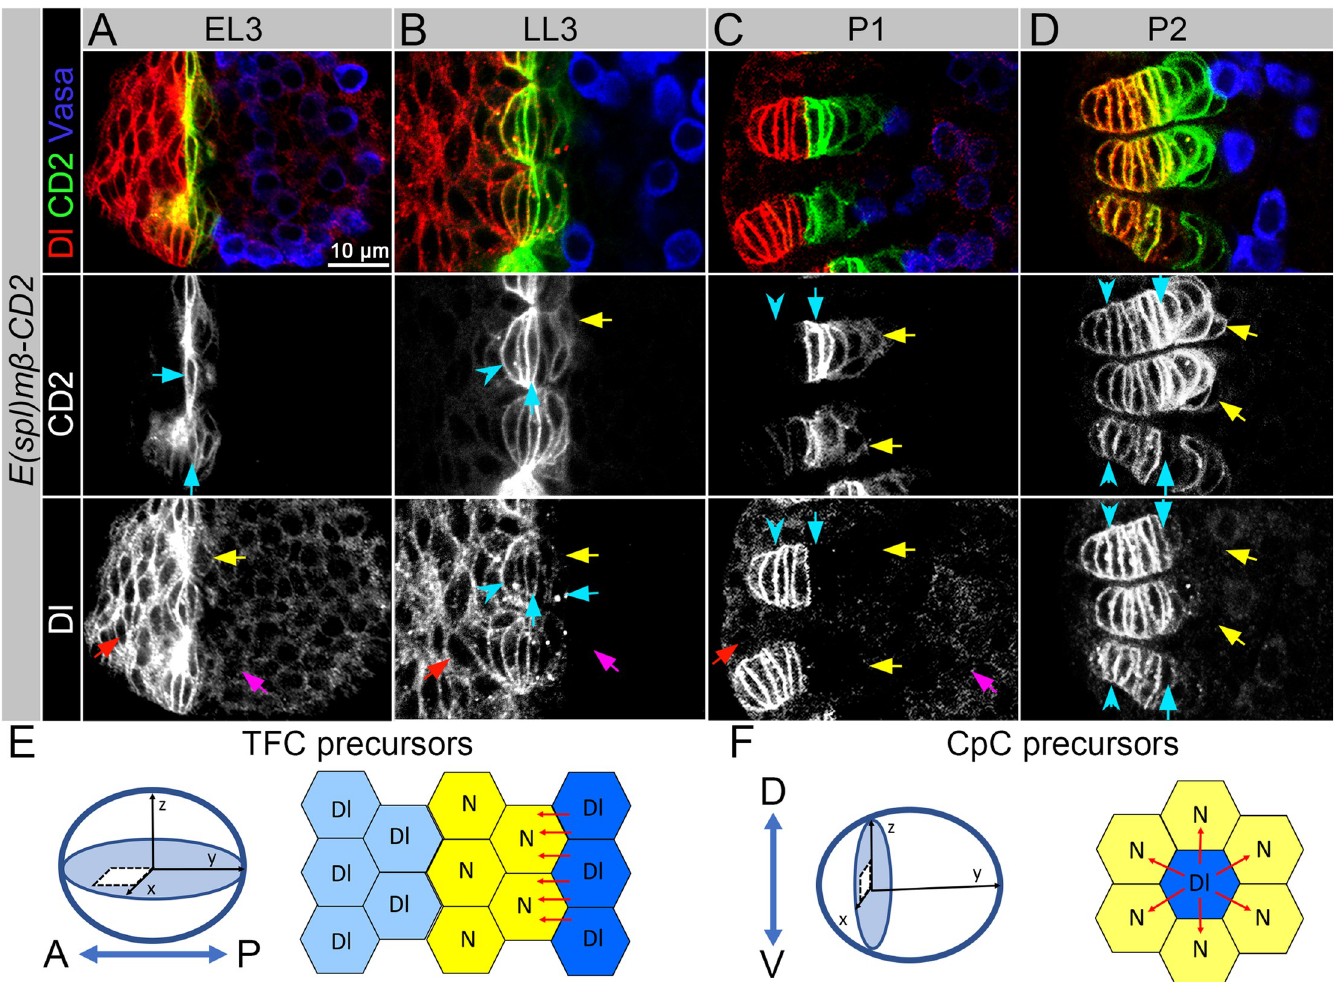
Fig 2. Patterning of Notch signaling at different stages of ovarian morphogenesis. ( A-D ) Co-expression of the Notch activity reporter ( E(Spl)mß-CD2 , green) and the Delta protein (red) in the developing ovaries. Vasa (blue) marks the germline. Single channels for the Notch activity reporter (CD2) and Delta (Dl) are shown below. At EL3 stage, Notch activity is first detected in the early TFCs ( A, cyan arrows). At LL3 and prepupa stages (P1 and P2), lower levels of Notch signaling activity are detected in CpCs ( B and C , yellow arrows) and higher levels in the posterior TFCs (cyan arrow). Note the absence of Notch signaling activity in the anterior TFCs (cyan arrowheads in LL3 and P1). After TFCs and CpCs are specialized, a dynamic Notch signaling activity pattern is observed in these cells (cyan arrow and arrowheads, P2). During all stages, Delta is expressed in ACs (red arrows) and in the germline ICs (magenta arrows); however, its expression levels notably decrease in these cells as organogenesis progresses. In TFCs, Delta expression shows complex dynamics, first, all TFC precursors have high levels of Delta (EL3), as TFCs are organized into individual stalks, Delta levels remain high in the anterior TFCs (cyan arrowheads) and are reduced (LL3) and then, absent (P1 and P2) in the posterior TFCs (cyan arrows). Note that some of the posterior TFCs have vesicle-internalized Delta (horizontal cyan arrow), which is important for Notch signaling activation and induction of the stem cell niche cell fate in CpC precursors ( B , yellow arrows). See also the images of the expression patterns of different Notch activity reporters (S2 Fig). (E-F ) GSC niche development is a two-step process, which includes TF formation and CpC specification. Schematics showing positioning and the proposed modes of Notch patterning induction within the developing ovary in TFC precursors ( E ) and CpC precursors ( F), based on [31]. Anterior $ Posterior (A $ P). Dorsal $ Ventral (D $